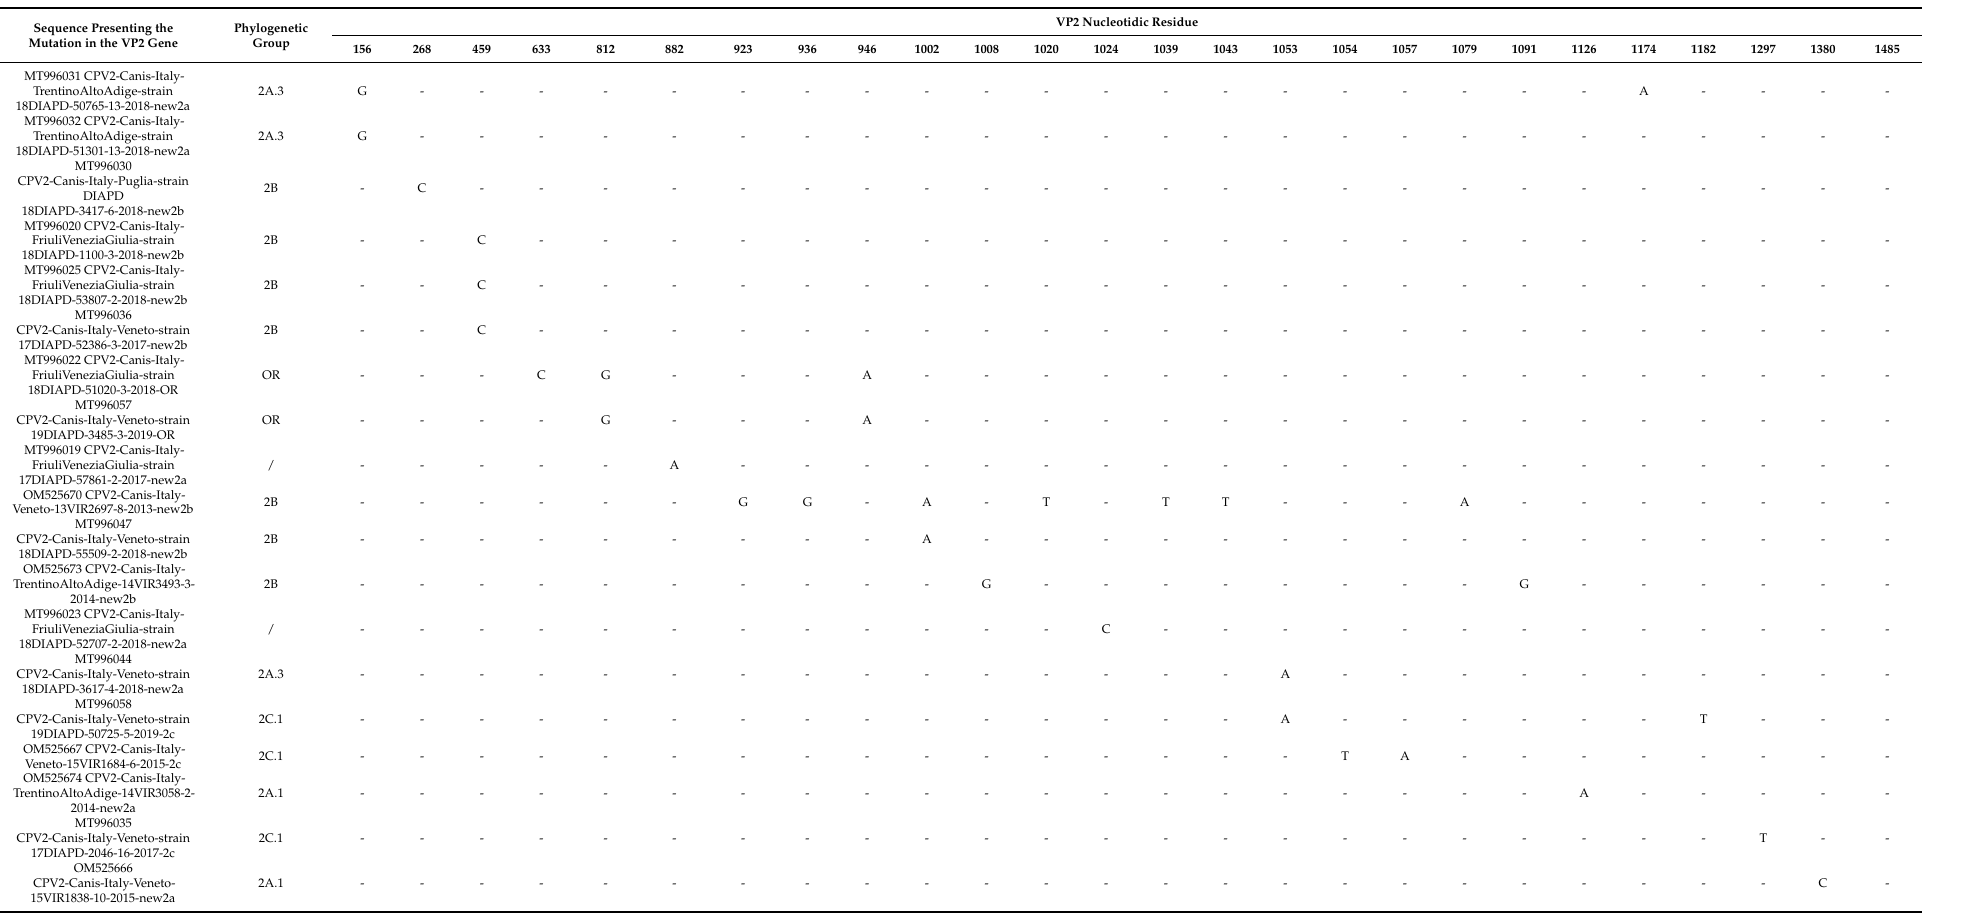
Table 2. Point-mutations identified in IZSVe sequences. Point-mutations in the VP2 gene of IZSVe sequences, the type of mutation (silent: sil, missense: mis and non-sense: ns) and the corresponding amino acid change (AA change). -: no changes